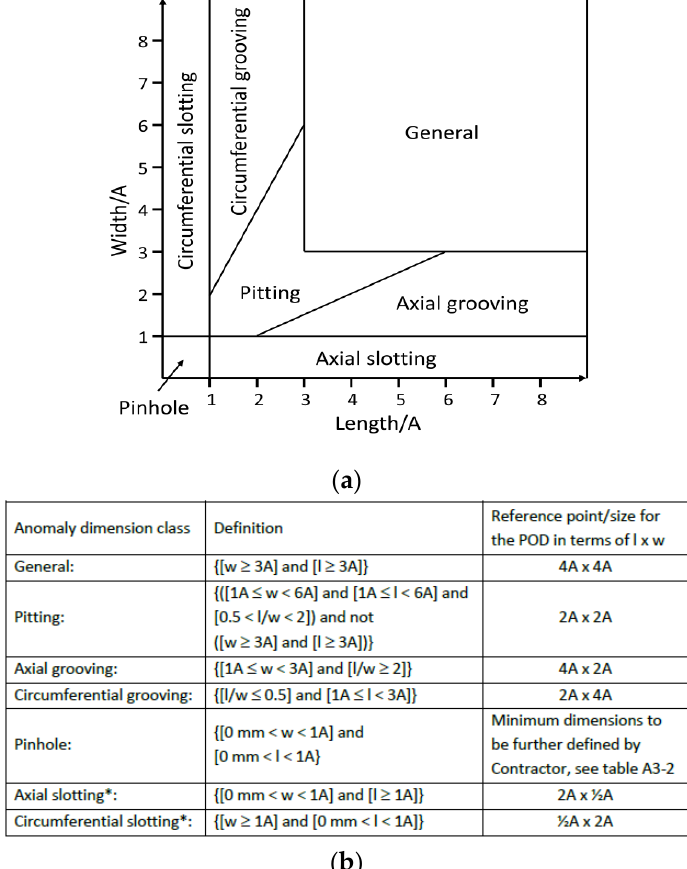
Figure 1. ( a ) Graphical presentation of surface dimensions of metal loss anomalies per dimension class; ( b ) definition of defect dimension class and MFL probability of Detection (POD) reference point/size [6]. * Anomalies with a width < 1mm are defined as crack of crack-like which might or might not be metal loss. Table A3-2 is in [6].